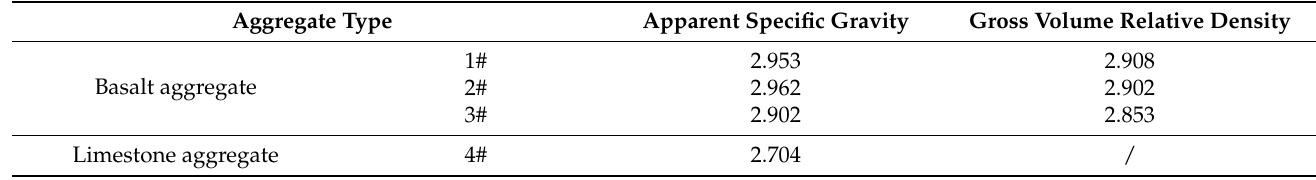
Table 3. Technical indexes of coarse and fine